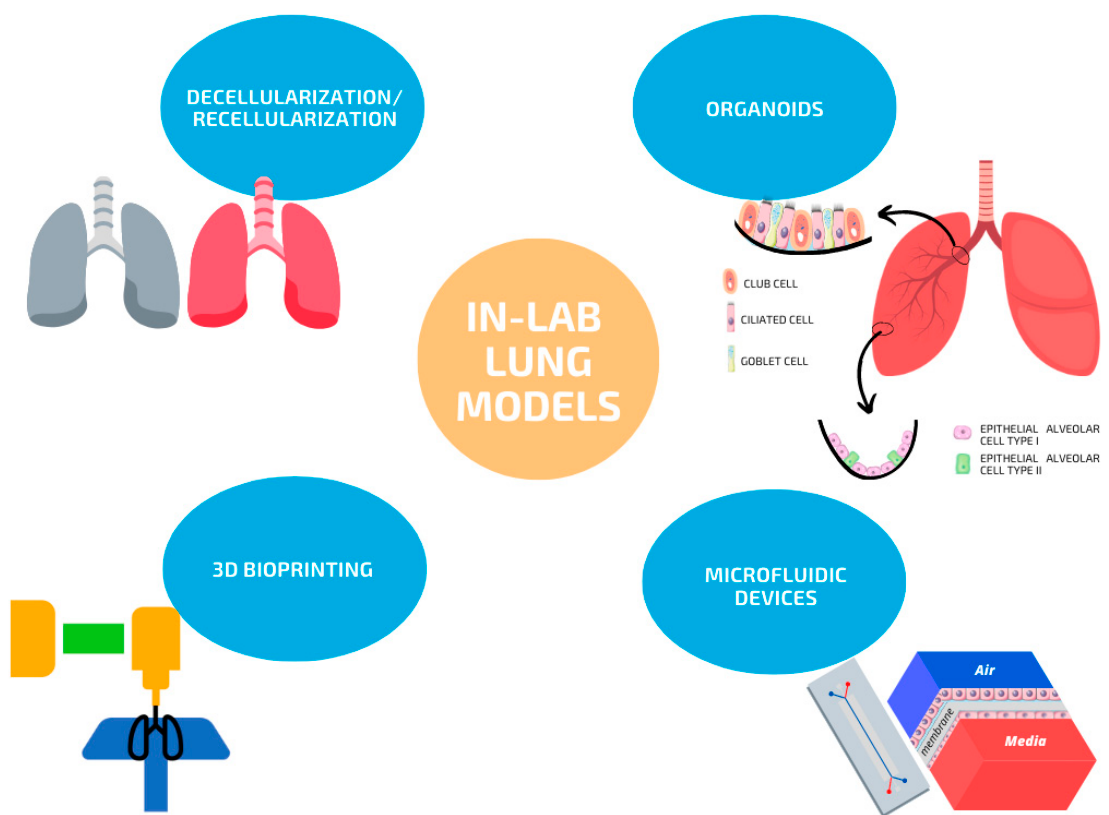
Figure 1. Overview of the current strategies available for in-lab lung models.